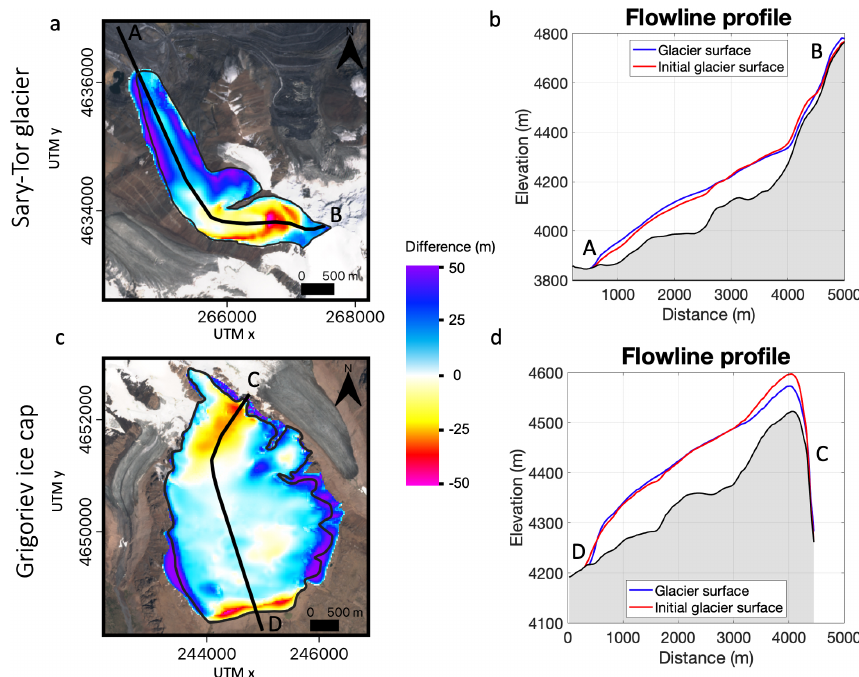
Figure 7. (a, c) Ice thickness difference between the modelled steady state ( ∼ 1960–1990 average climatic conditions) and the reconstructed geometry of 1990. The used flowline is added on the map with a black line. (b, d) Reconstructed (initial glacier surface) and modelled (glacier surface) ice thickness along the central flowlines. Panels (a) and (b) are for the Sary-Tor glacier, and panels (c) and (d) are for the Grigoriev ice cap. The background of the left maps is a Sentinel-2 image from 26 July 2021. The outlines are from